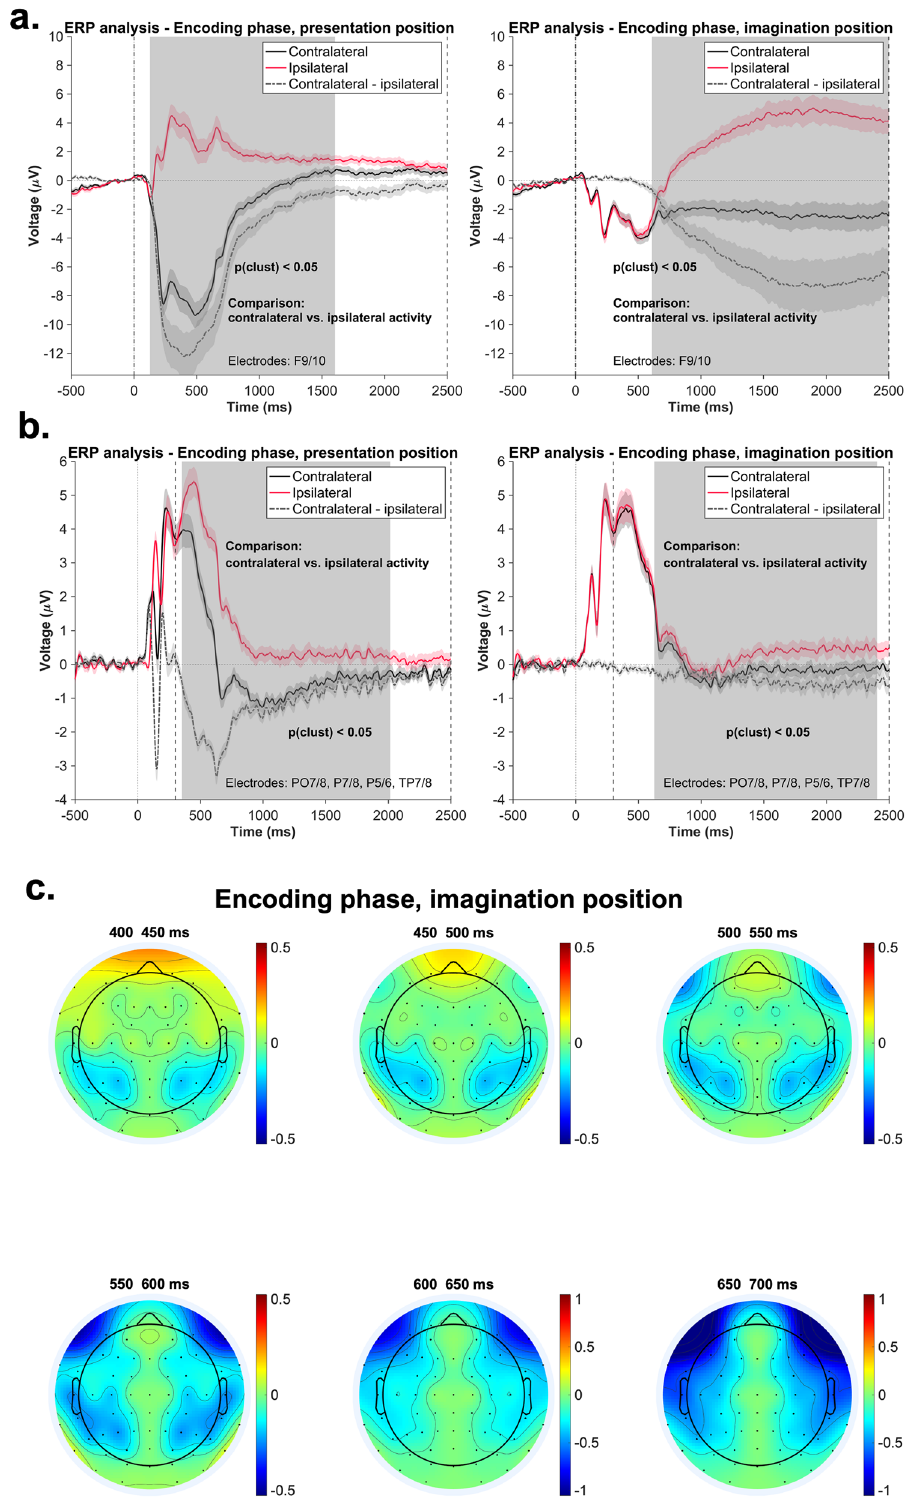
Figure 6. Results of the ERP analysis–encoding phase. The shaded area represents the standard error of the mean activity. a . Time course of the contralateral, ipsilateral, and contralateral-minus-ipsilateral frontal ERP activity during the encoding phase, with respect to presentation position (left) and imagination postion (right). The contralateral and ipsilateral activity was contrasted using a cluster-based permutation approach for the time-window: 0–2500 ms, as indicated by the dotted lines. The significant clusters are marked with gray. b . Time course of the contralateral, ipsilateral, and contralateral-minus-ipsilateral posterior ERP activity during the encoding phase, with respect to presentation position (left) and imagination postion (right). The contralateral and ipsilateral activity was contrasted using a cluster-based permutation approach for the time-window: 0–2500 ms, as indicated by the dotted lines. The significant clusters are marked with gray. c . Time course of the topographical distribution of the contralateral-minus-ipsilateral ERP activity relative to the imagination